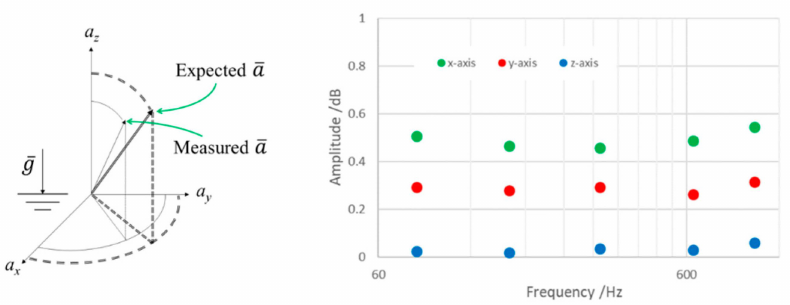
Figure 11. Quantification of differences between the measured acceleration and expected